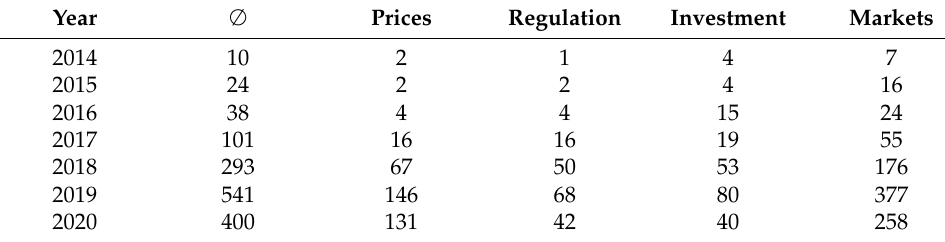
Table 1. Number of papers indexed in Web of Science within 2014–2010 for the search “cryptos AND”. Year ∅ Prices Regulation Investment Markets